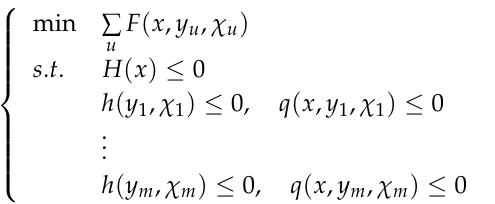
P and max P . It should be noted that, and P max . It should be noted that, P min w w w w